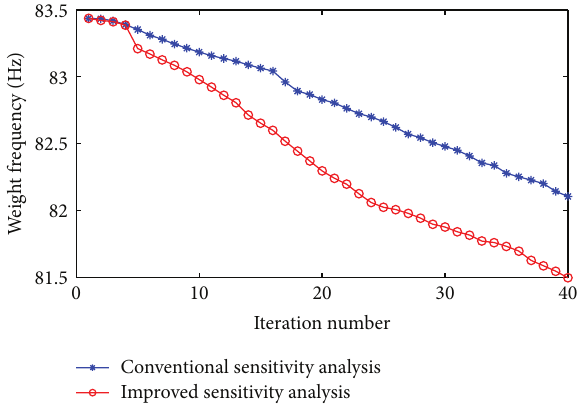
Figure 12: Iteration histories of the frequency.